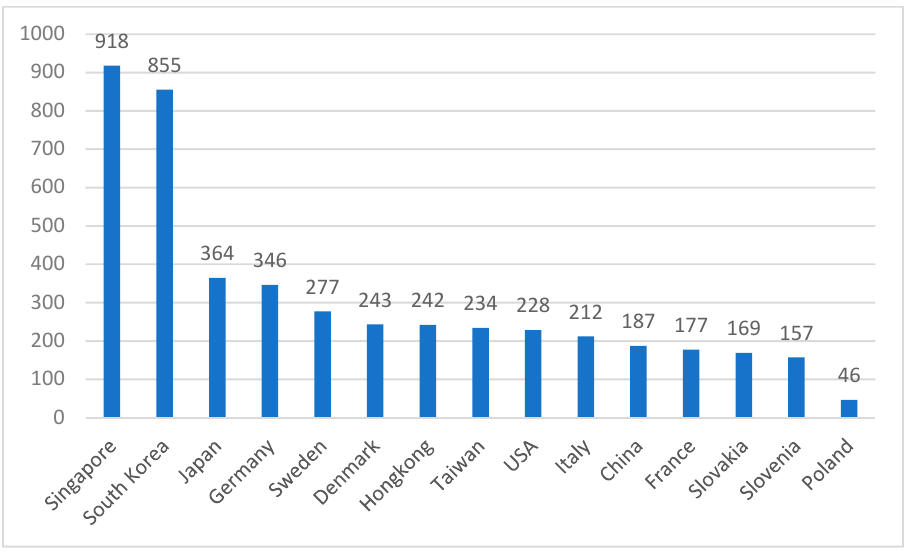
Figure 1. The number of robots per 10,000 employees in selected countries. Source: ZPB 2021.